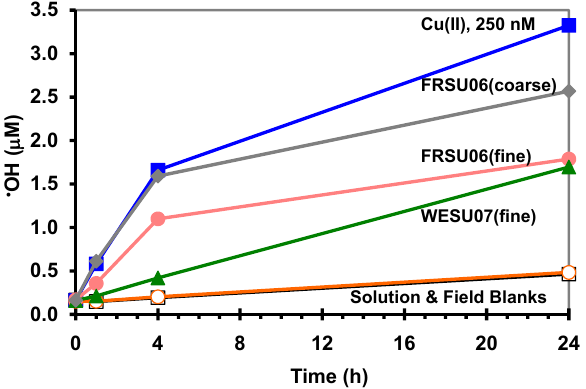
Fig. 2. Examples of • OH generation from fine and coarse San Joaquin Valley particles extracted in a surrogate lung fluid contain- ing 50µM ascorbate. Sample nomenclature: FRSU06 = Fresno summer 2006, WESU07 = Westside summer 2007, 250nM Cu (II) = positive